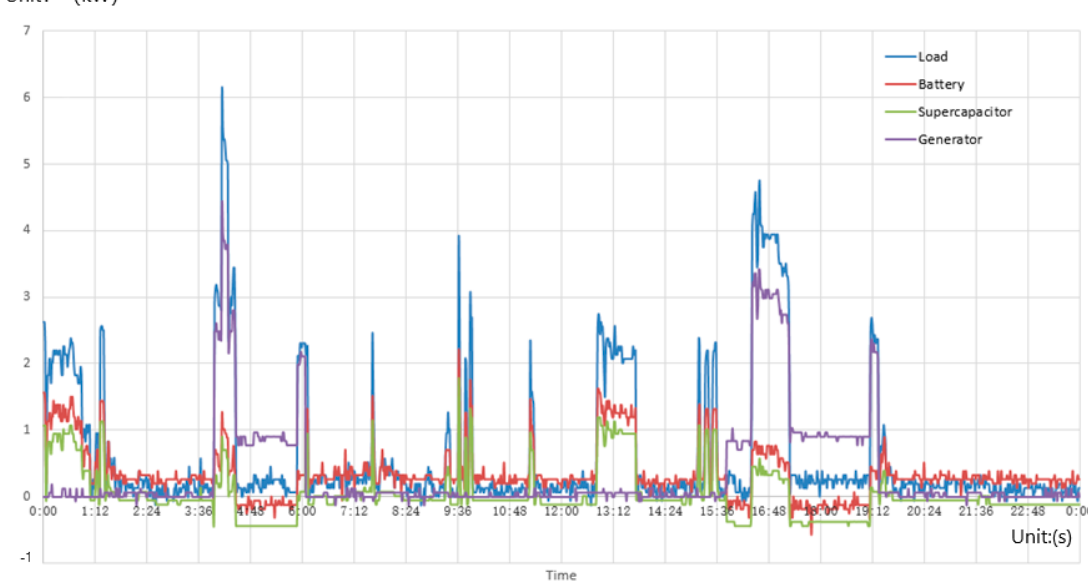
Figure 4 A typical summer day load test result. Figure 4. A typical summer day load test